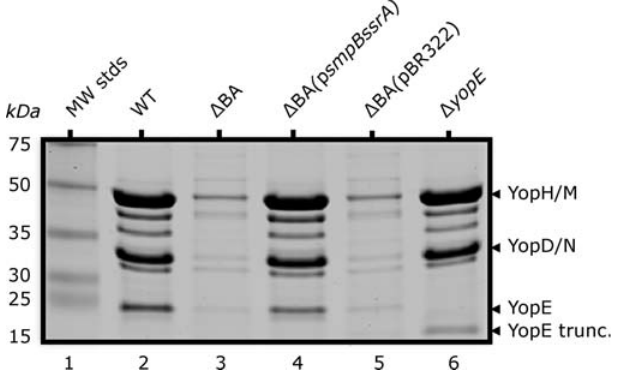
Figure 6. The D BA Mutant Is Defective in Secretion of Yops Bacterial cultures of indicated strains of Y. pseudotuberculosis were grown in low-calcium medium, and cells were harvested 3.5 h after temperature shift to 37 8 C. Culture supernatants were precipitated with TCA, and the protein pellets were resolved by electrophoresis on 10%-polyacrylamide Tris-tricine gel, and stained with Coomassie Brilliant Blue. The D yopE strain was used as a reference. MW stds, protein molecular weight standards; WT, wild type. DOI: